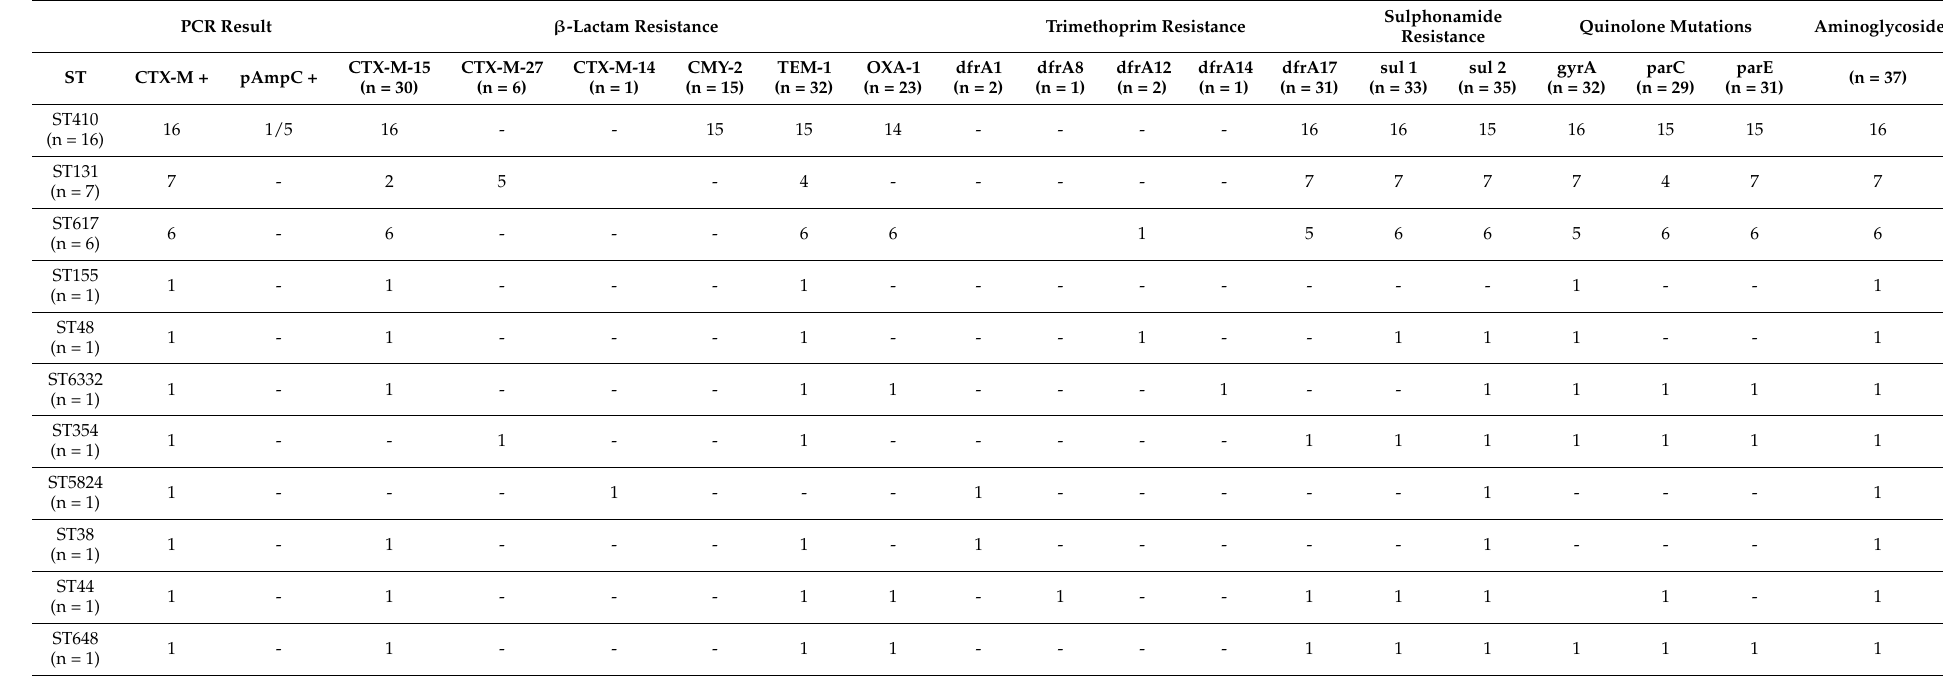
Table 1. ST-distribution and clinical important antimicrobial resistance determinants in E. coli strains (n =